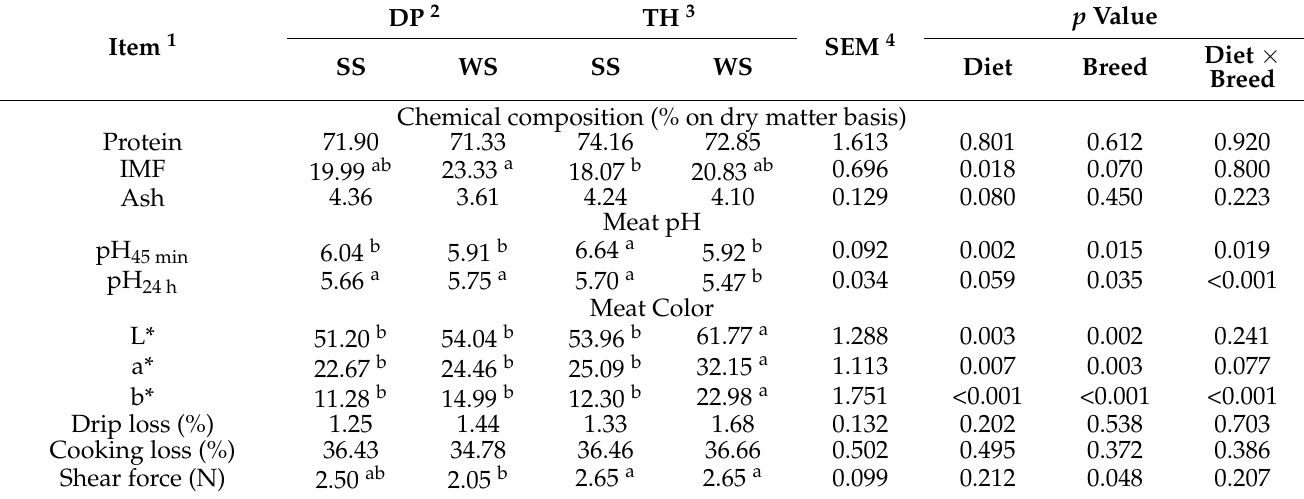
Table 4. Effect of silage diet and breed on physical–chemical composition of longissimus dorsi ( n = 7 per group).